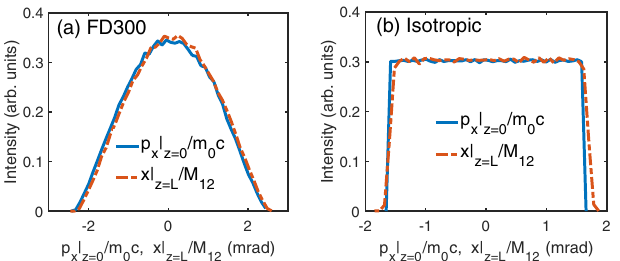
FIG. 4. A comparison between the initial transverse momentum distribution and the transverse projection of the image at the screen. The FD300 model and isotropic model in ASTRA simu- lation are used as examples to generate electrons with different momentum distribution, shown in (a) and (b) respectively.